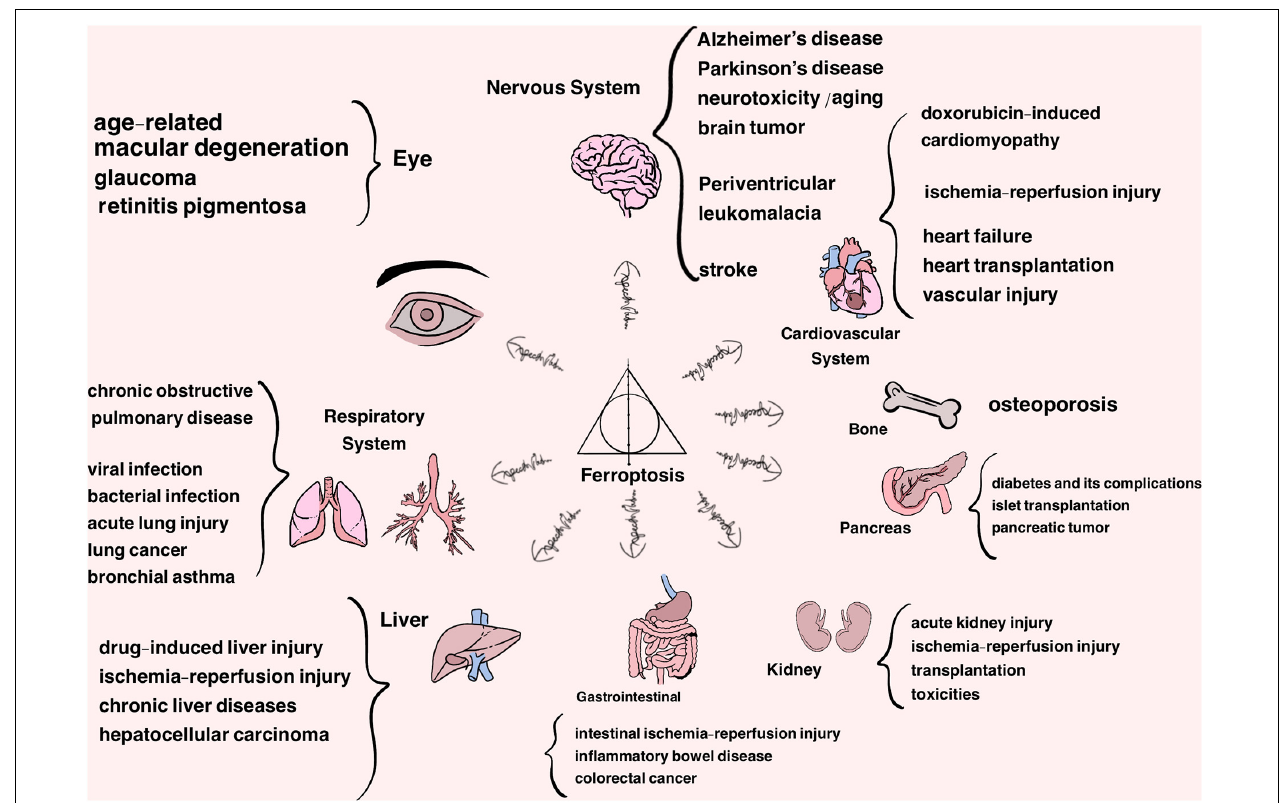
FIGURE 1 | Ferroptosis is approved to participate in the progression of a variety of organs and system diseases, listed